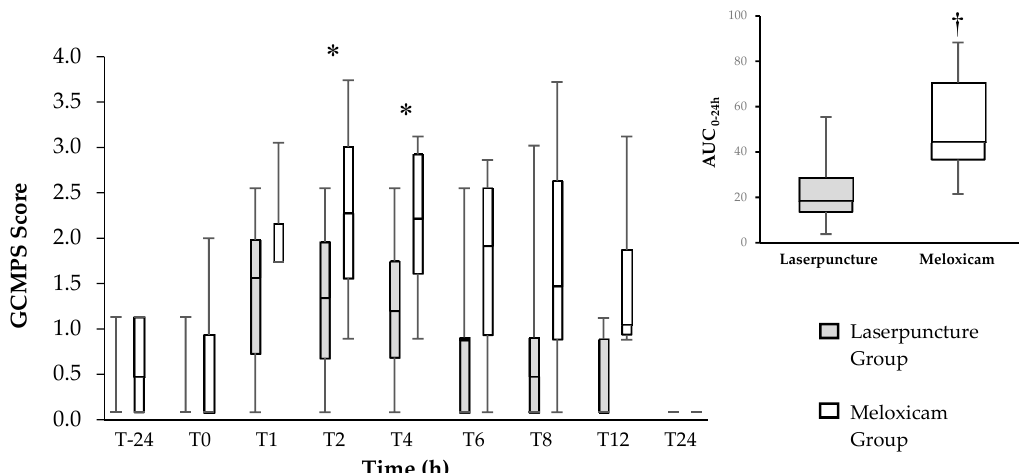
Figure 1. Left —Box plot of the Glasgow Composite Measure Pain Scale (GCMPS) scores over time (center horizontal lines express the medians; box limits indicate the 25th and 75th percentiles, whiskers extend 1.5 times the interquartile range from the 25th and 75th percentiles) for 16 bitches treated preoperatively with laserpuncture ( n = 8) or meloxicam ( n = 8) and submitted to ovariohysterectomy. * Indicates the di ff erences between groups at T2 ( p = 0.042) and T4 ( p = 0.022) according to Mann–Whitney test. Right —Box plot of the area under the curve (AUC) of the GCMPS scores (center horizontal lines express the medians; box limits indicate the 25th and 75th percentiles, whiskers extend 10th and 90th percentiles) between 0–24 h. † Indicates di ff erence between groups ( p = 0.007).